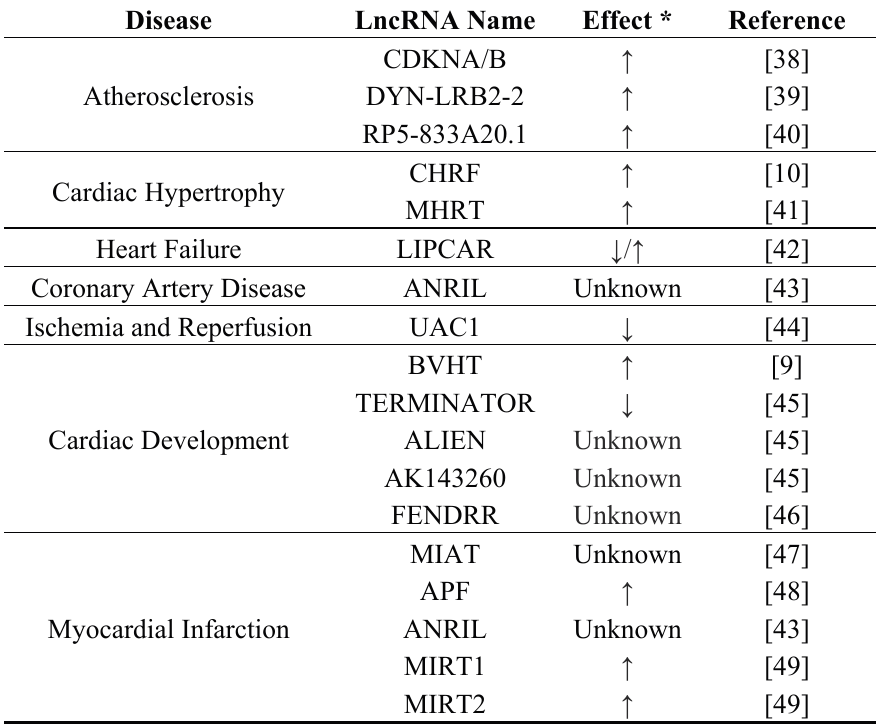
Table 1. LncRNAs associated with cardiovascular development and